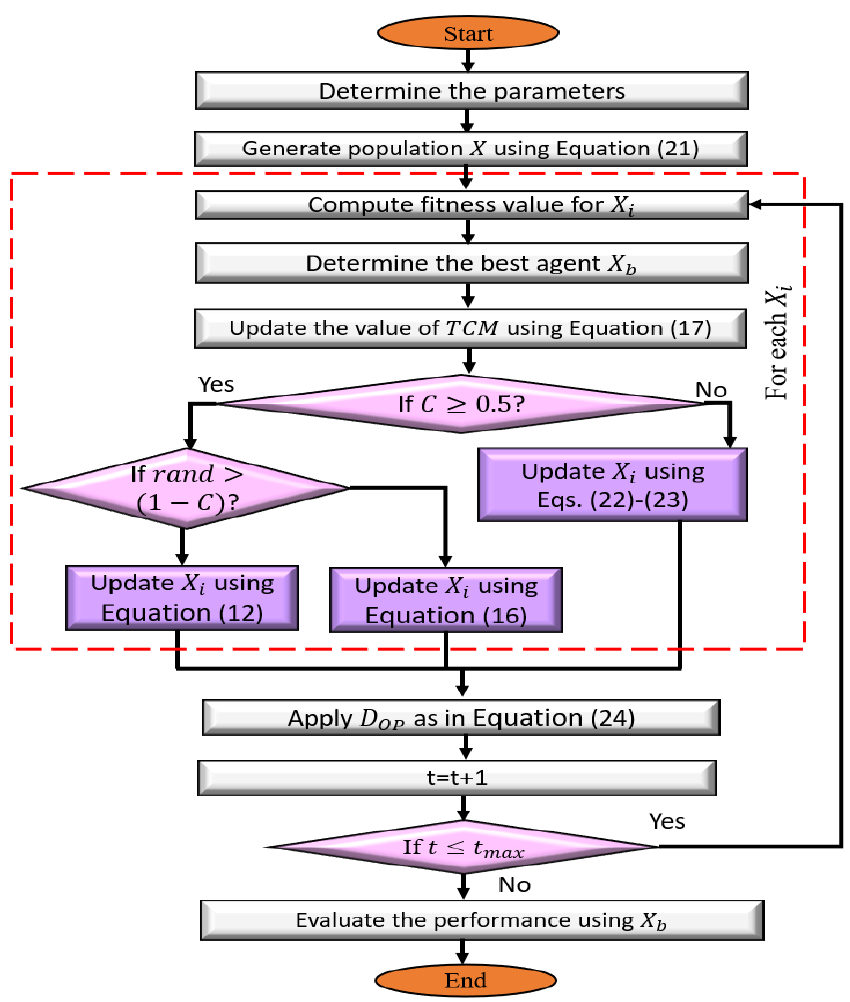
Figure 1. Schematic flowchart of the developed DJSD